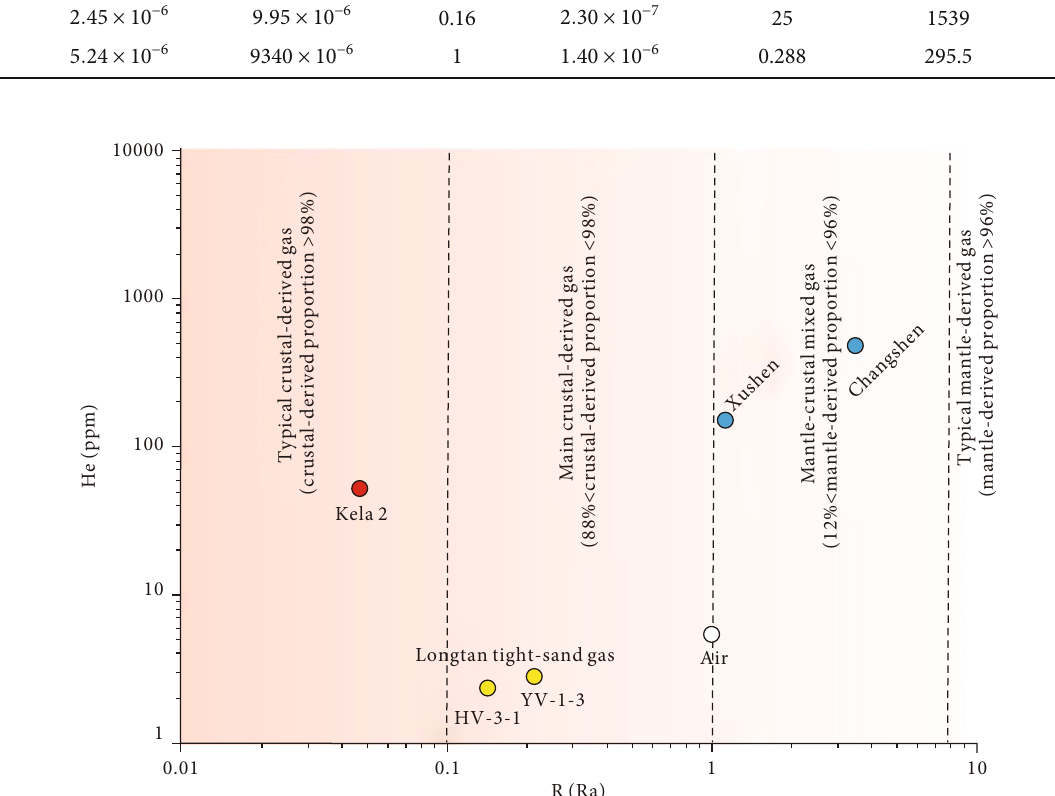
Figure 9: Crossplots of R/Ra versus He concentration of typical gas fi elds in China and Longtan tight sand gas in west Guizhou, showing that the Longtan R/Ra values are in the range of values for main crustal-derived gas. The data of Kela2, Xushen, and Changshen are from Wang et al. [50].